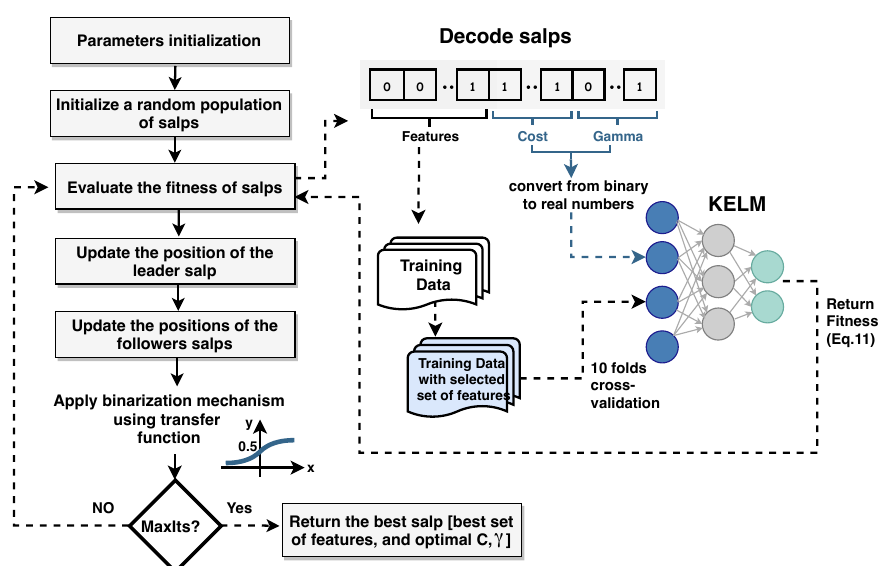
Figure 7. A structural representation of the methodology flow that describes the process of searching for the optimal set of features and the best